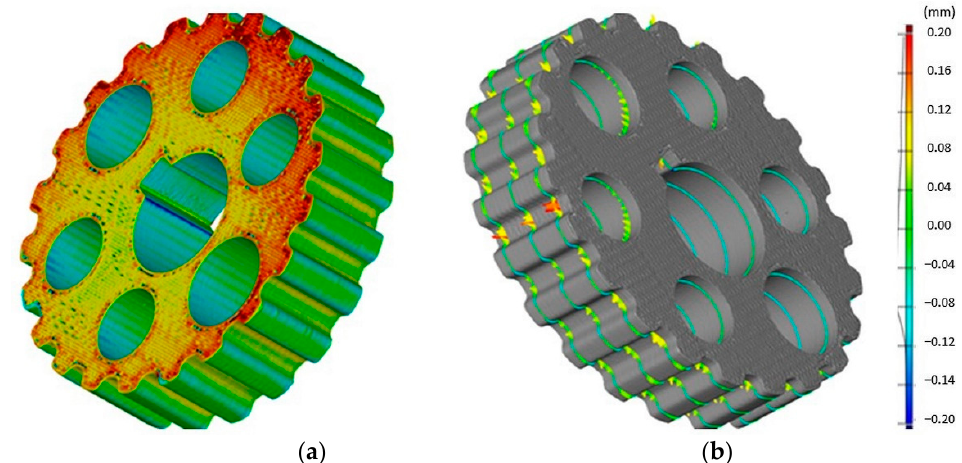
Figure 7. Assessment of the geometrical features of the wheel made with the FDM method using the GOM system ( a ) comparison of the CAD model and the model obtained as a result of scanning, ( b ) the CAD model of the wheel with sections selected to the evaluation.